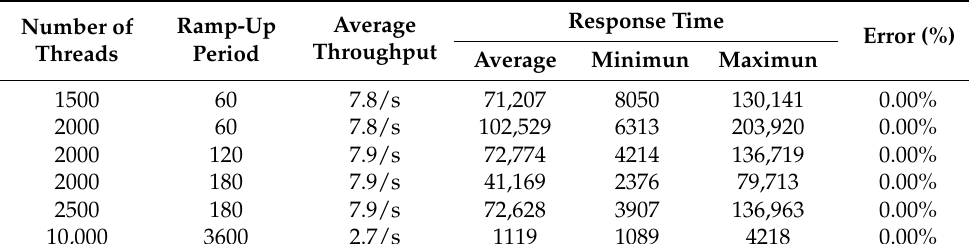
Table 16. Apache JMeter metrics of the reservation service.